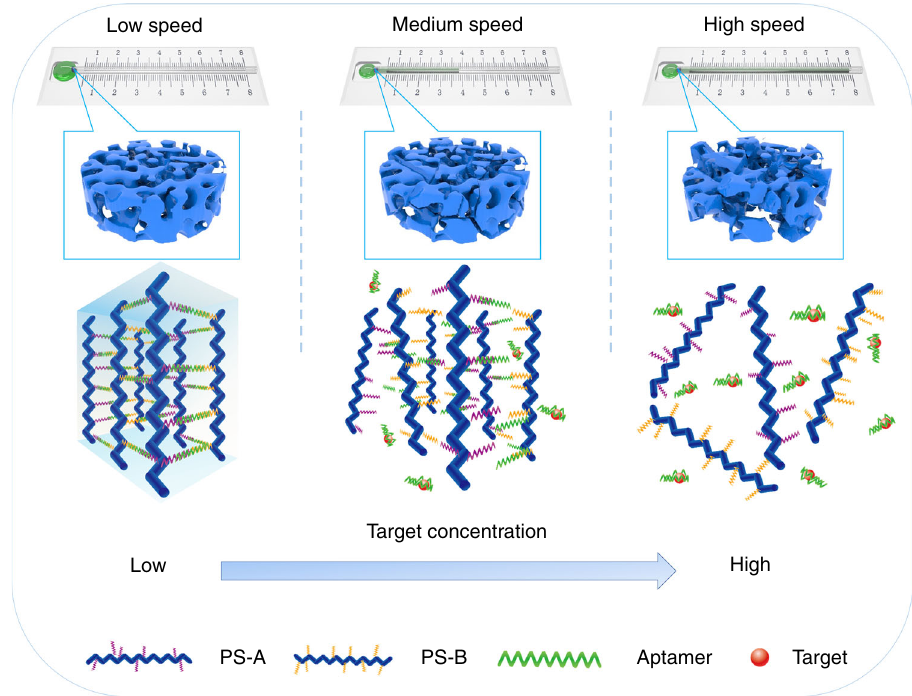
Fig. 3 The working principle of the CSDR-Sensor. The addition of target will result in the degradation of hydrogel to a certain degree, and then change the permeability of gel in capillary tube and regulate the capillary action via membrane